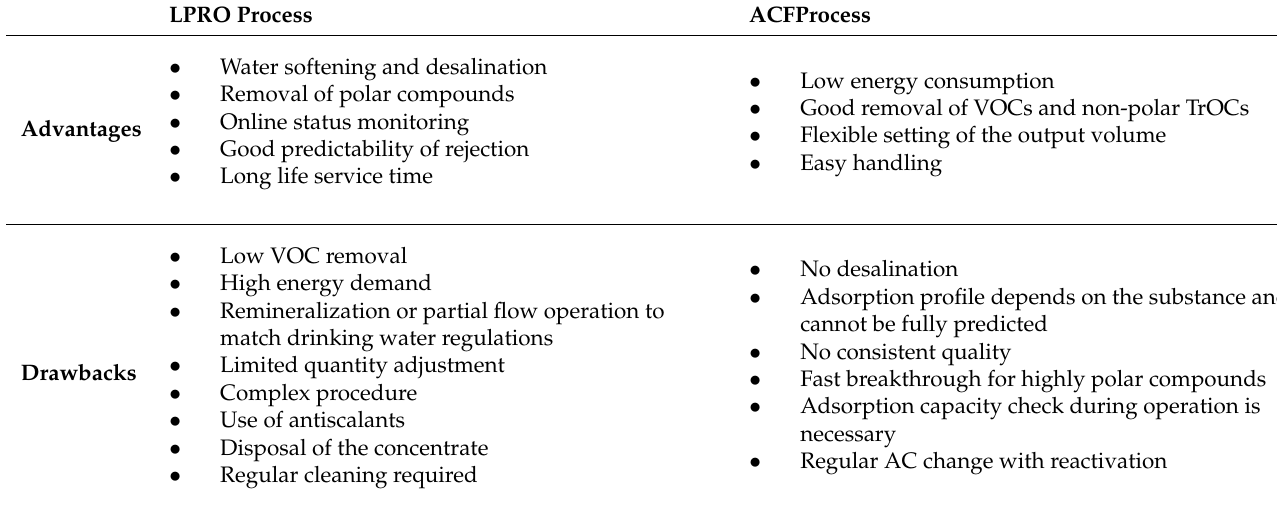
Table 8. Advantages and disadvantages for individual LPRO and ACF processes.